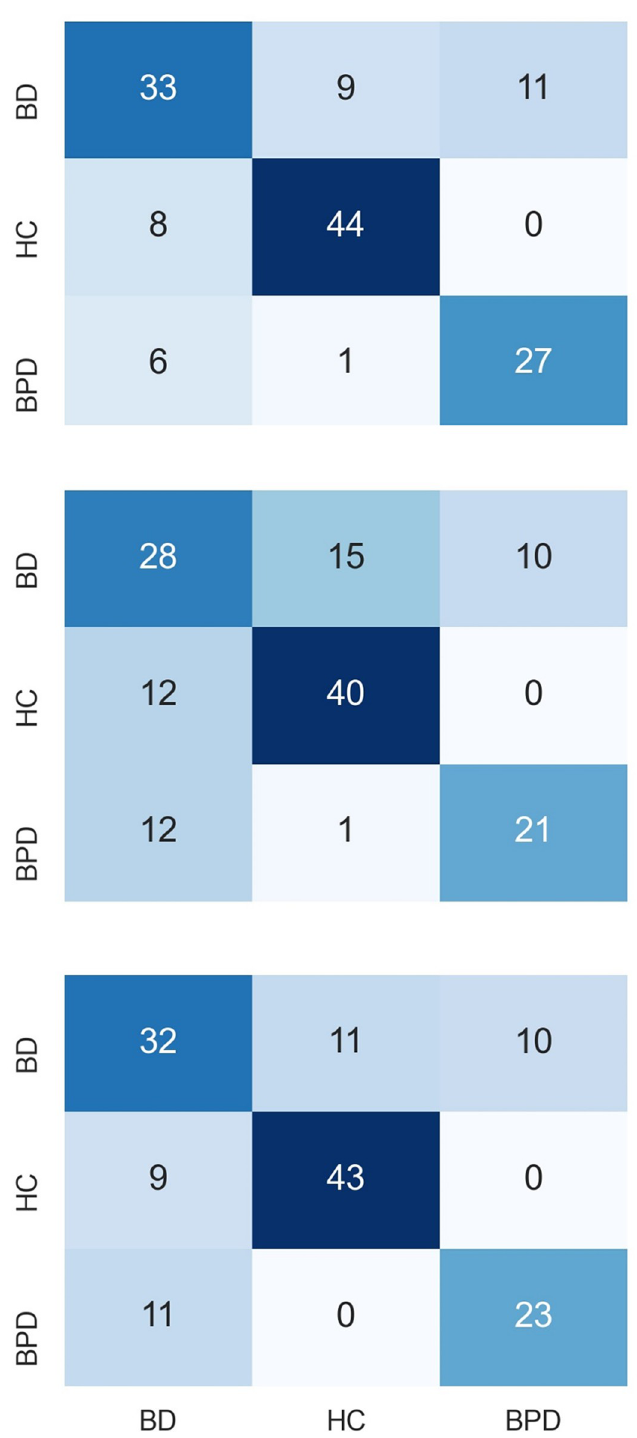
Fig 4. Confusion matrices of MRLSM, the naive model and KNN model. Upper: MRLSM. Middle: the naive model. Bottom: KNN.